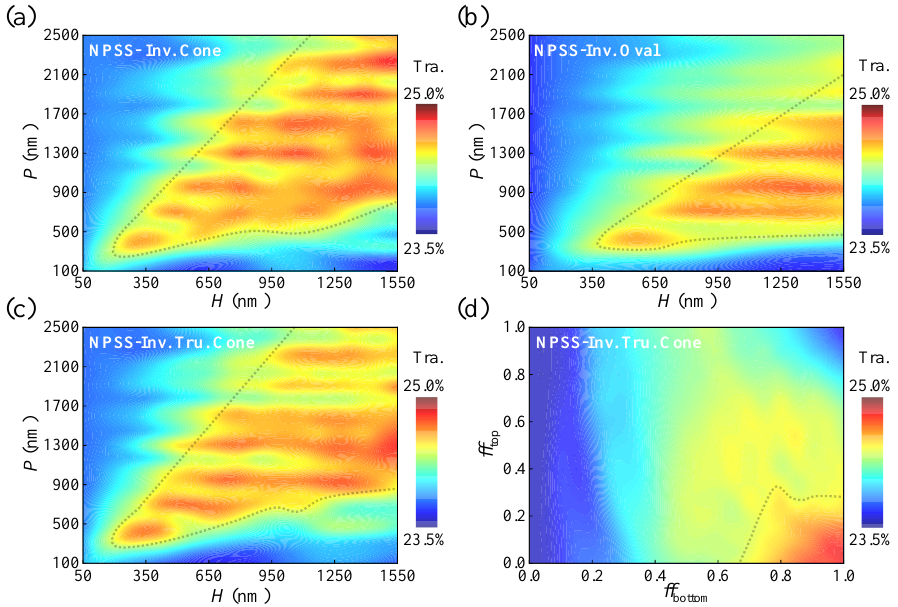
Figure 5. The dependence of the period P and height H on the average transmittances for ( a ) the inverted cone-shape patterned NPSS (NPSS-Inv. Cone), ( b ) inverted oval-shape patterned NPSS (NPSS-Inv. Oval), and ( c ) inverted truncated cone-shape patterned NPSS (NPSS-Inv. Tru. Cone) structures. Here, ff was fixed at 1 for cases of NPSS-Cone and NPSS-Oval, and ff bottom ( ff top ) was fixed at 0.95 (0.2) for the case of NPSS-Tru. Cone. ( d ) The average transmittances of NPSS-Inv. Tru. Cone structure under the various ff bottom and ff top .